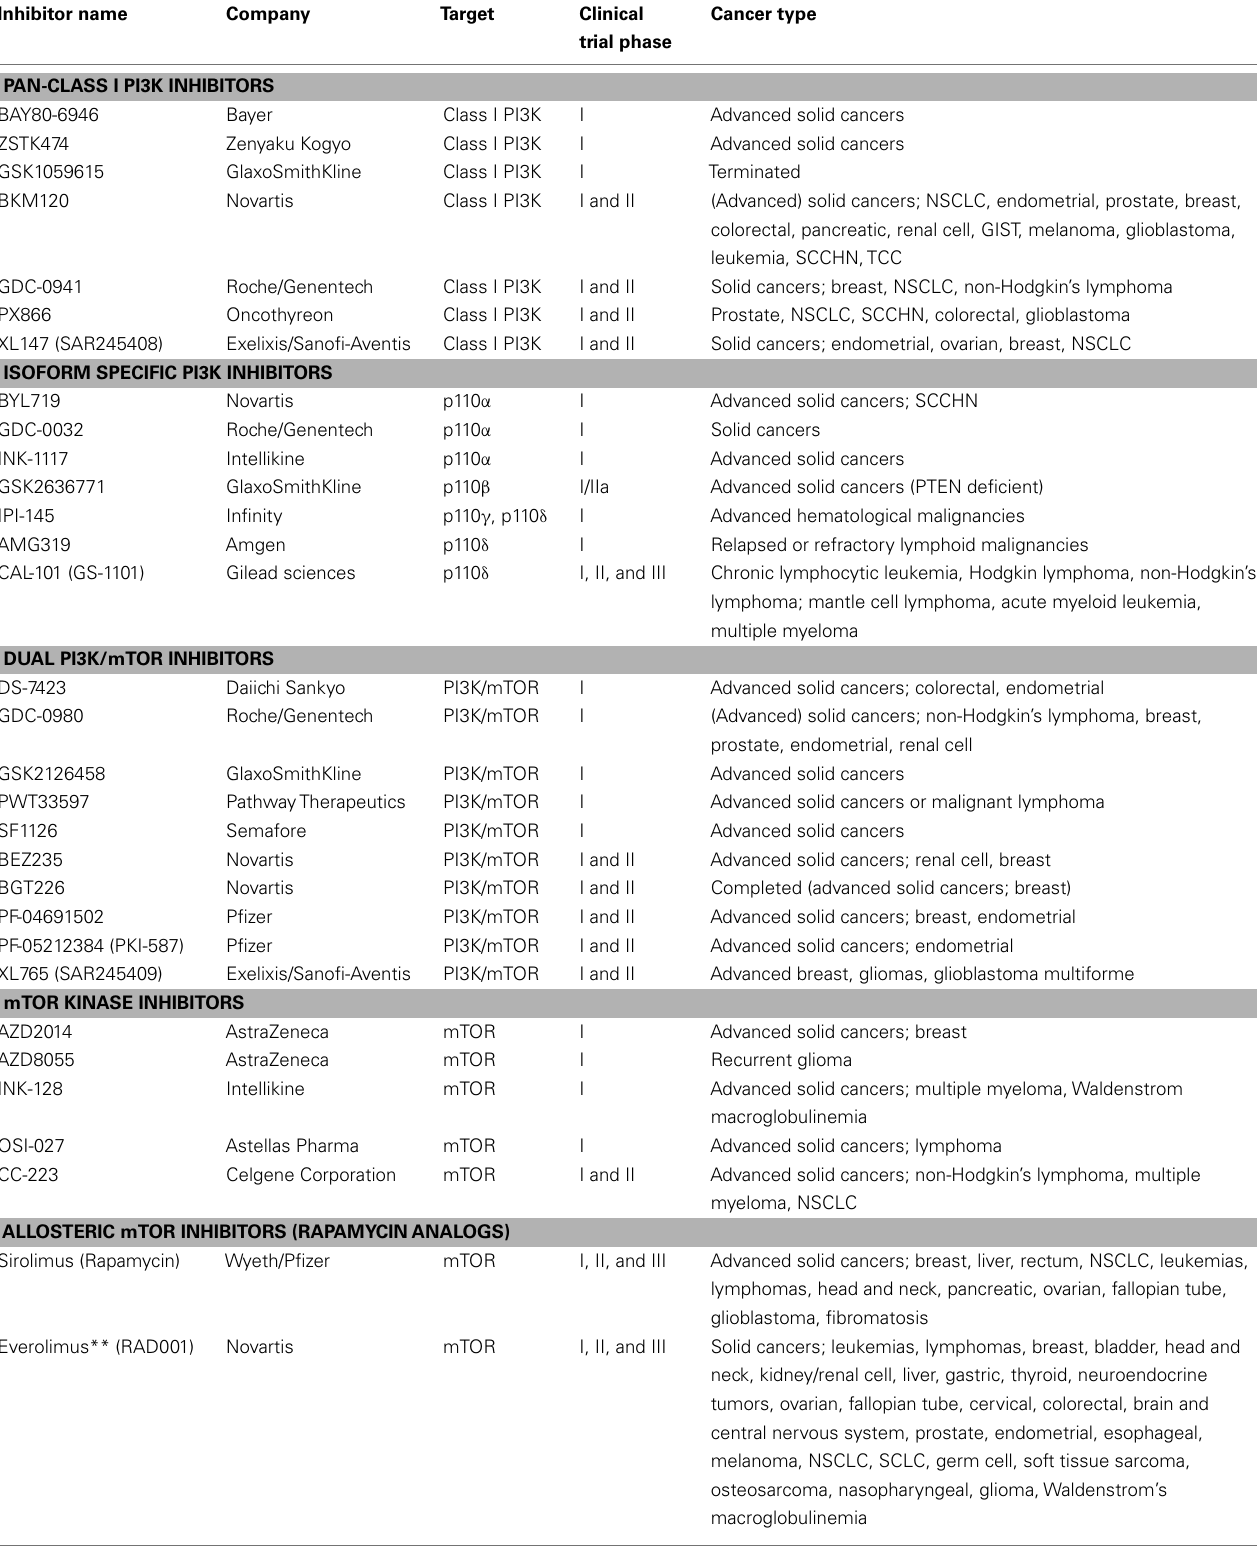
Table 1 | Open clinical trials testing PI3K pathway inhibitors in